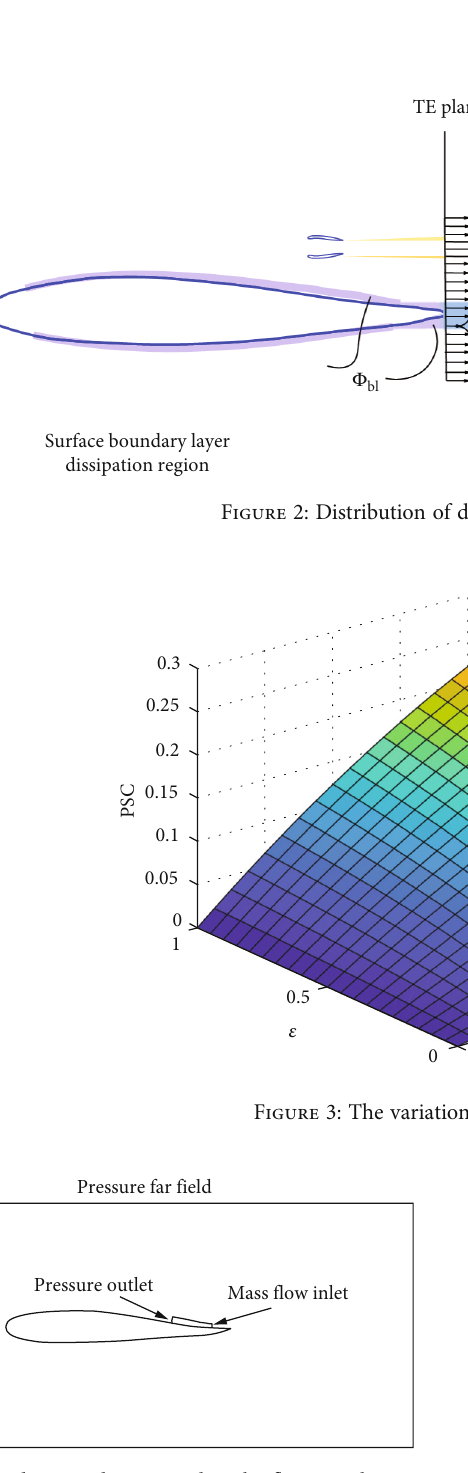
Figure 4: Boundary conditions used in the fl ow